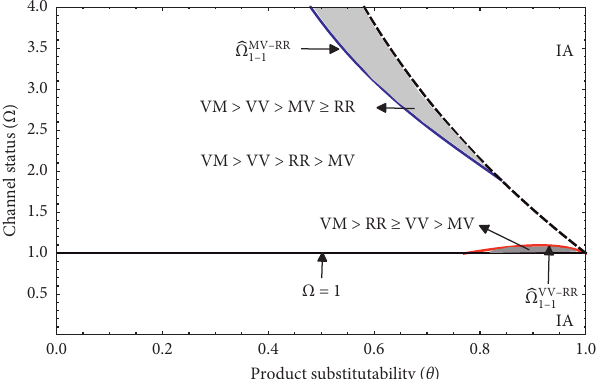
Figure 7: Comparison with respect to channel 1 efficiency among all